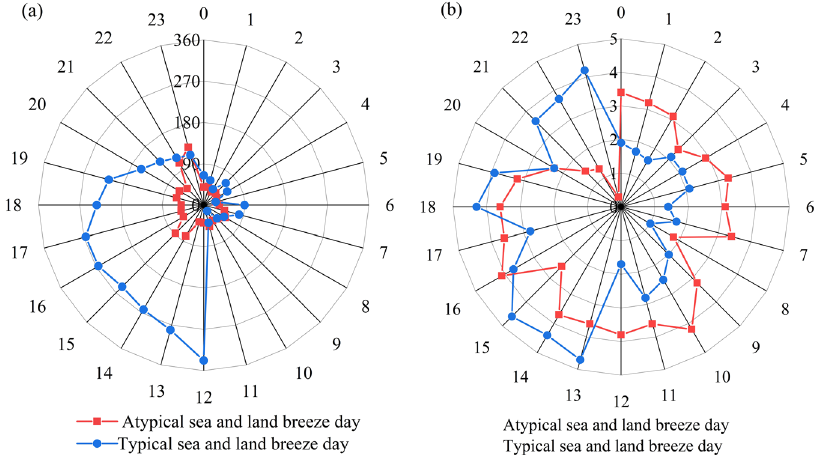
Fig. 4 Diurnal changes in wind speed and direction between typical sea and land breeze day and atypical sea and land breeze day. a Wind direction, b wind speed.